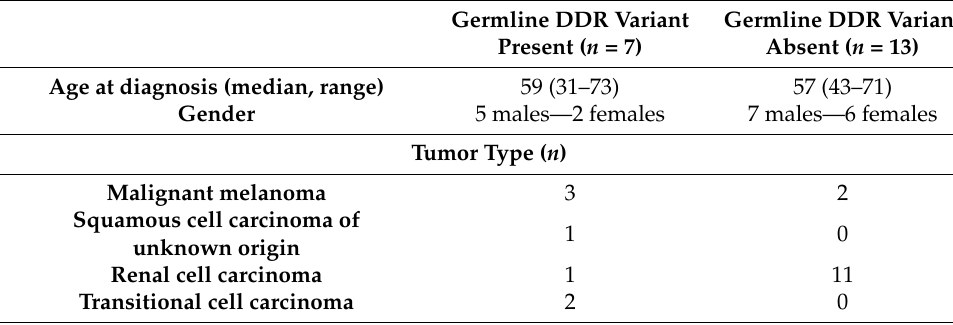
Table 1. Baseline